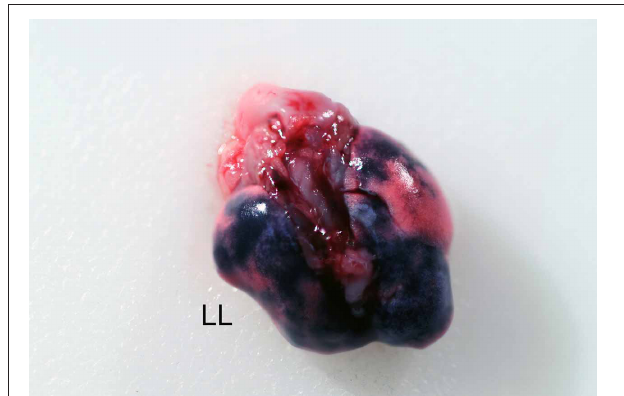
FIGURE 3 | Intratracheal delivery of trypan blue. Mice were anesthetized with 2.5% isoflurane and instilled with 20 µ l of a 0.4% trypan blue solution. Mice were euthanized and the lungs harvested. Left lobe (LL) is labeled for